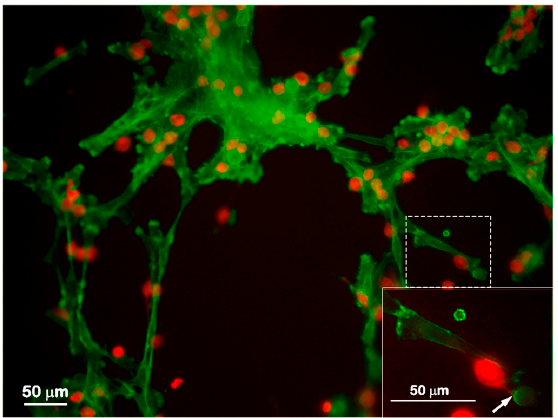
Figure 3. Mast cells are in close approximation to endothelial cells. SVEC4-10 cells co-cultured with P815 mast cells. SVEC4-10 cells were labeled with CellTracker™ Green CMFDA and P815 mast cells were labeled with CellTracker™ Red CMTPX. After 5 h of co-culture, SVEC4-10 cells (green) and P815 mast cells (red) are associated. Mast cells are in contact with endothelial cells (arrow). Inset: High magnification of the area delimited by dotted line. Image is representative of four independent experiments.